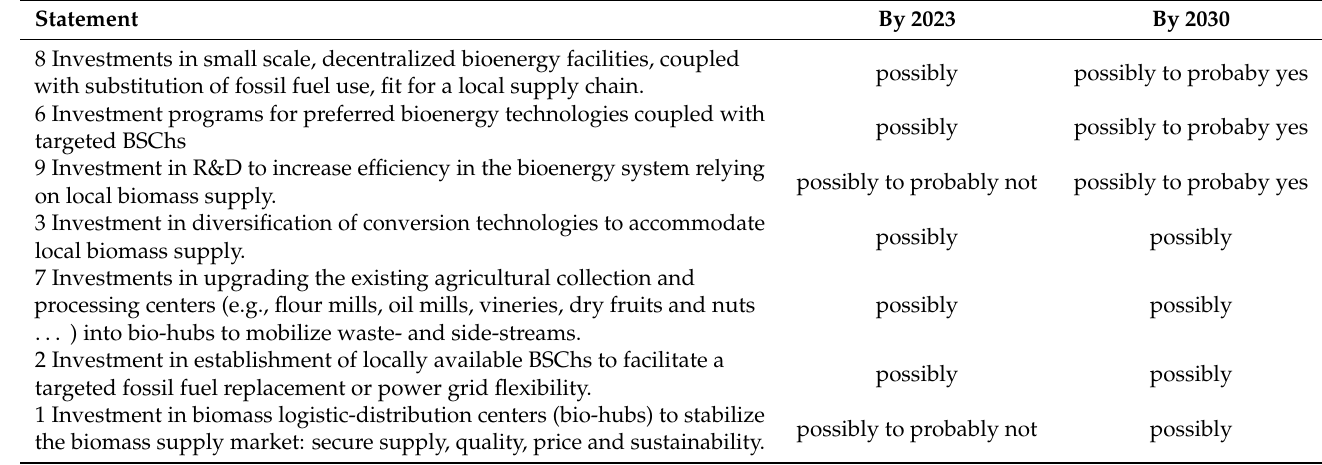
Table 9. Aggregated experts’ consensus on the impact of the investments in BSChs on building cleaner and more resilient energy systems, across different scenarios.